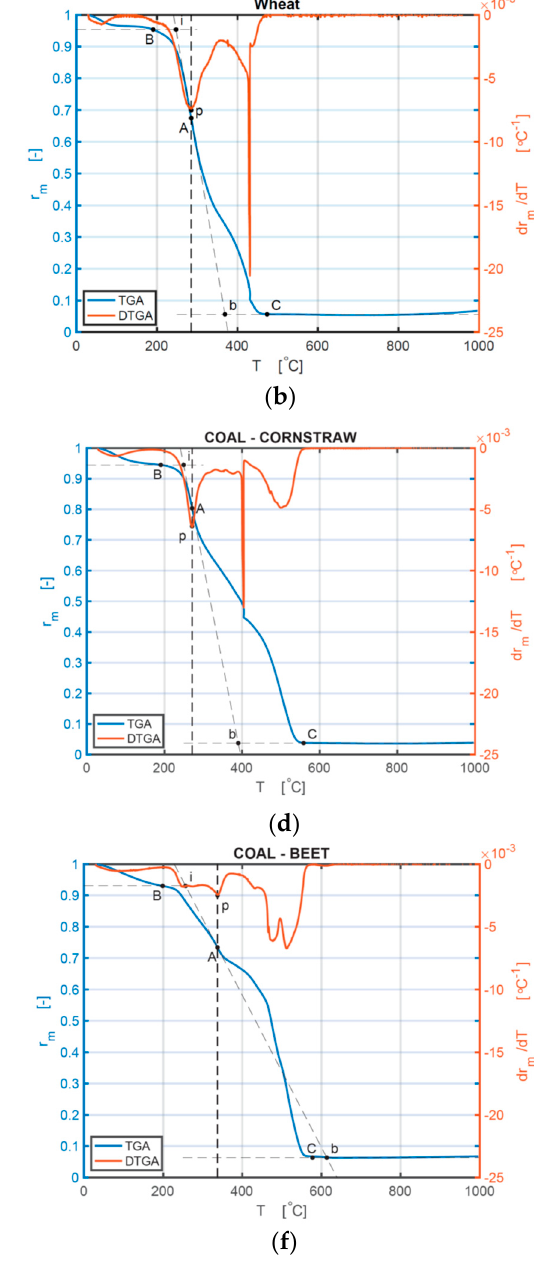
Figure 2. ( a – f ) TG and DTG curves of the samples of CS, wheat, BR, CCSB, CWB, and CBRB 10 °C/min: ( a ) TG and DTG curves of CS; ( b ) TG and DTG curves of wheat; ( c ) TG and DTG curves of BR; ( d ) TG and DTG curves of CCSB; ( e ) TG and DTG curves of CWB; ( f ) TG and DTG curves of CBRB. Table 2. T i , T b , and T max of all samples.